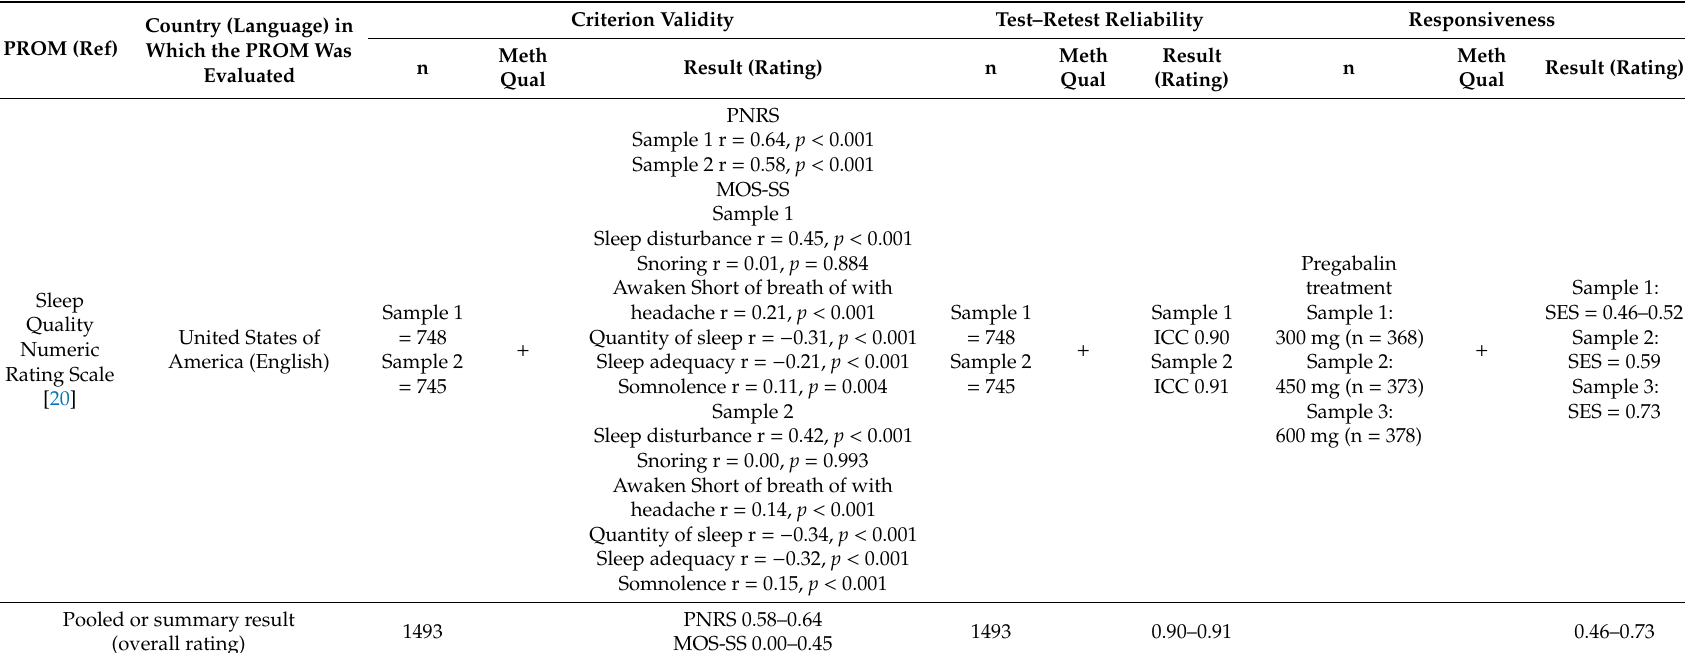
Table 7. Results of studies on measurement properties